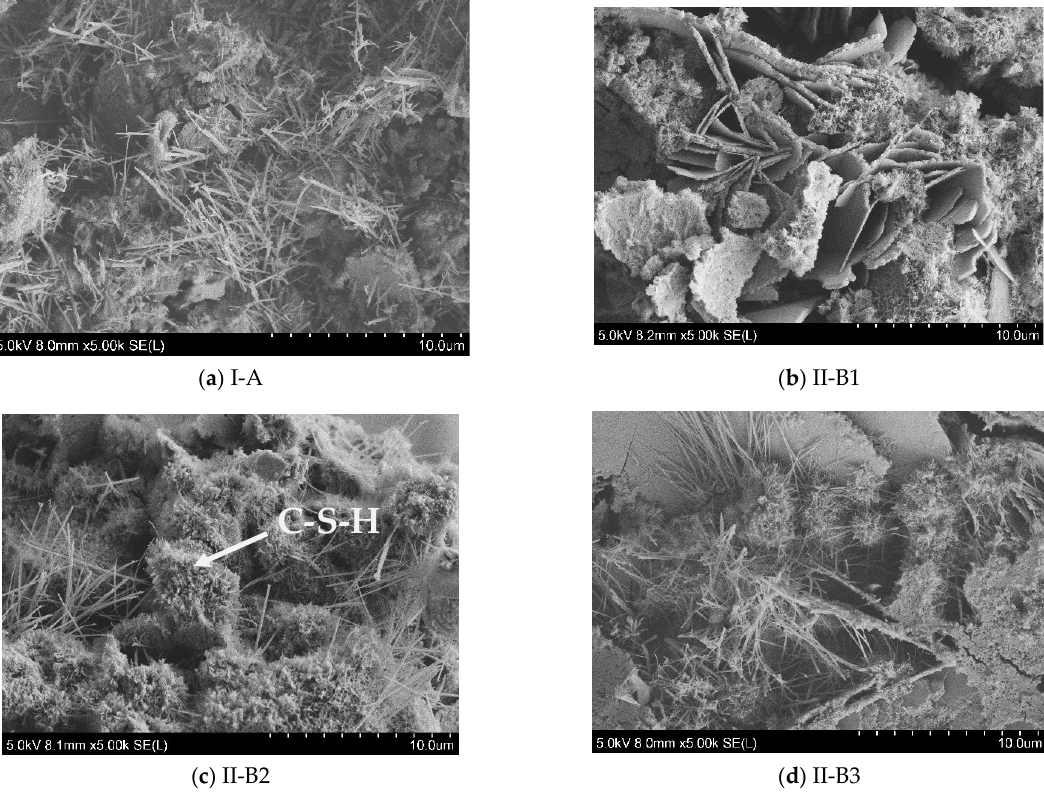
Figure 6. SEM electron micrographs of hydration products at 7 days: ( a ) reference group mortar after 7-day hydration; ( b ) mortar with alkanolamine-A incorporated after 7-day hydration; ( c ) mortar with calcium nitrate after 7-day hydration; ( d ) mortar with alkanolamine-B after 7-day